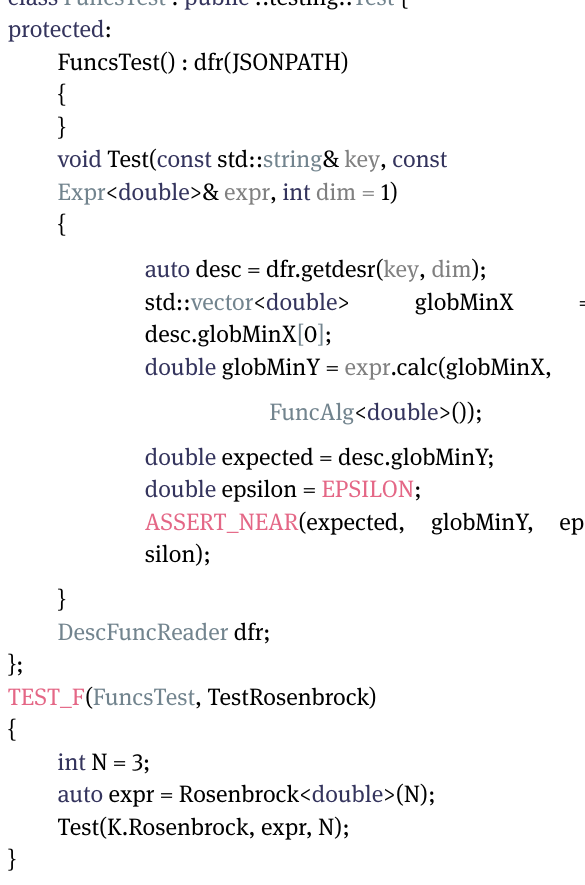
Figure 14: Testing the value of Rosenbrock function.